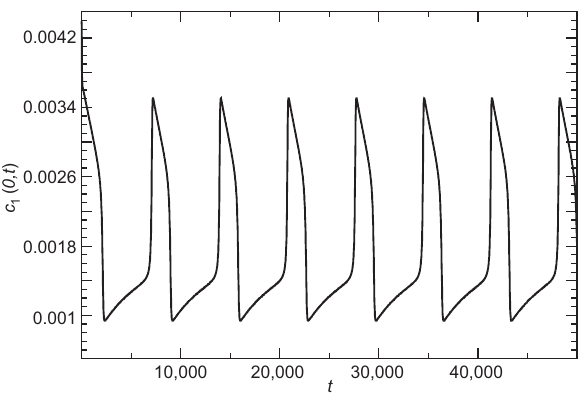
Figure 4 Temporal evolution of R